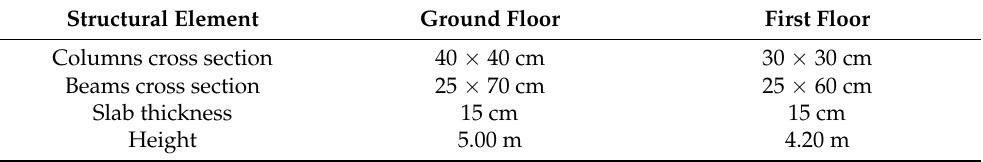
Table 1. Geometry of the structural